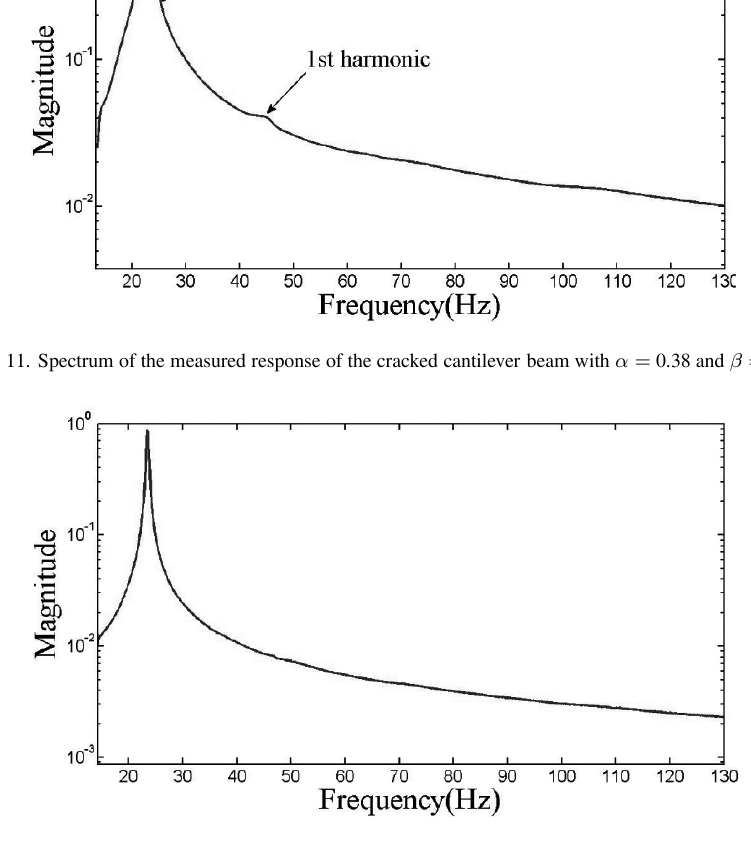
Fig. 12. Spectrum of the measured response of the intact